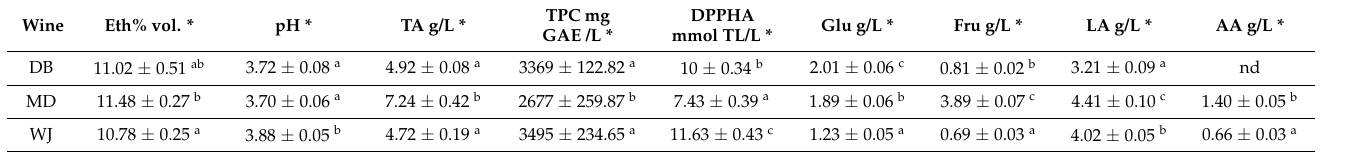
Table 4. Analysis of key parameters of red